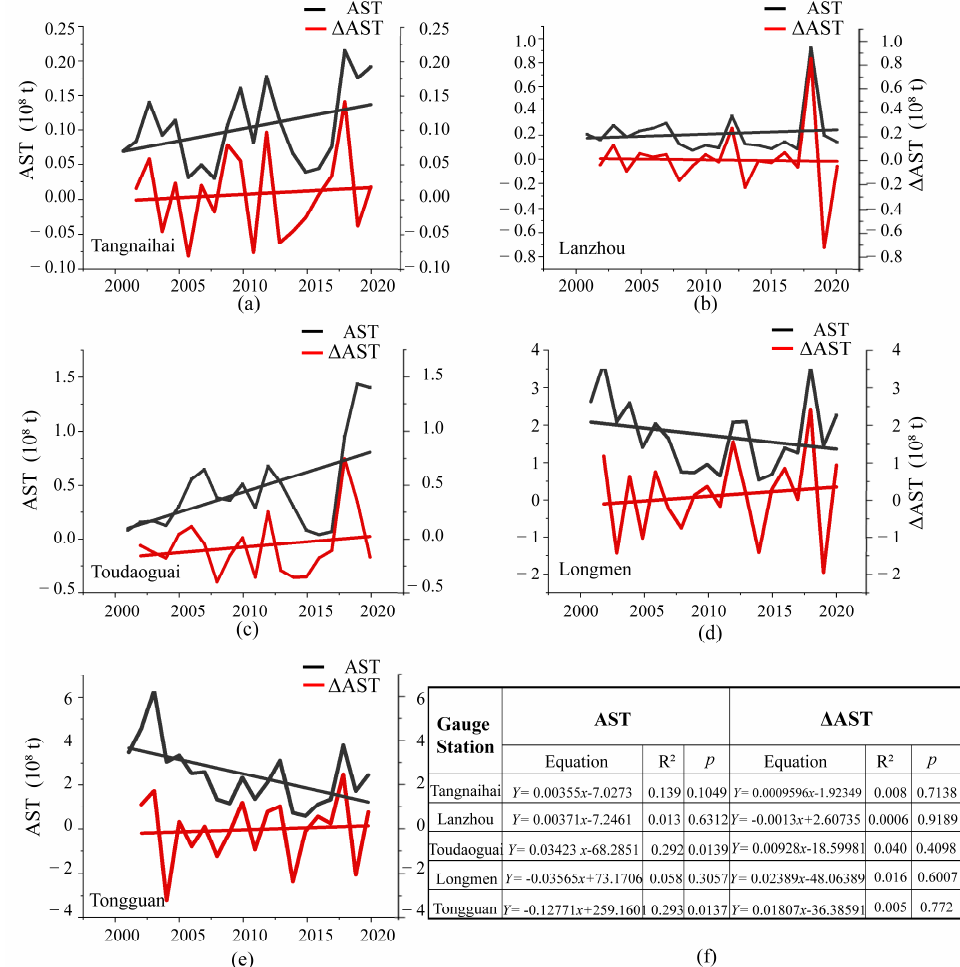
Figure 3. Variation trend in AST and Δ AST in the UMRYR, showing the gauge stations in the URYR ( a – c ) and the gauge stations in the MRYR ( d , e ), and the equation for the variation trend in the AST and Δ AST in the UMRYR ( f ). The abbreviations, AST and Δ AST, denote the annual sediment transport and the amount of interannual variation in the annual sediment transport, respectively. The abbreviations, UMRYR and MRYR, denote the upper and the middle reaches of the Yellow River, respectively. At the same time, after the fi rst-order di ff erence of the AST , the Δ AST was almost unchanged in the UMRYR (red line in Figure 3), and the p values were all greater than 0.05. The temporal trend in fl uence of the AST in the UMRYR was e ff ectively eliminated by the fi rst-order di ff erence. The driving factors in this study were treated in the same way. The processed data ( Δ AST) had no autocorrelation, therefore, they were used for the sta- tistical analysis.